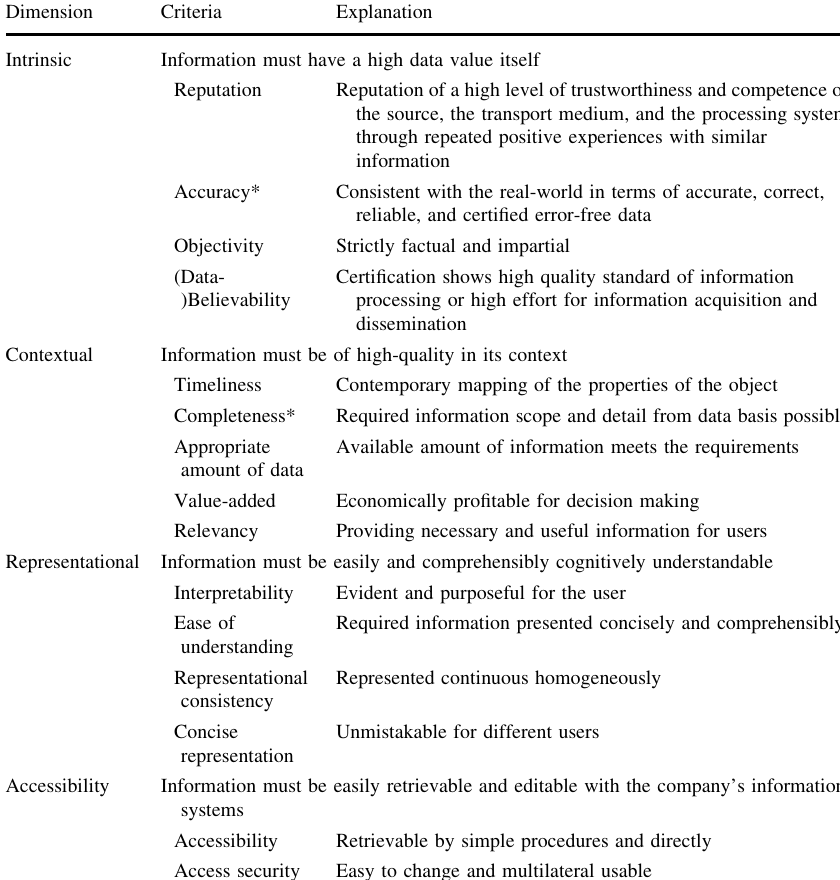
Table 2 Criteria for the quality of information (Wang and Strong 1996; Rohweder et al. 2015)